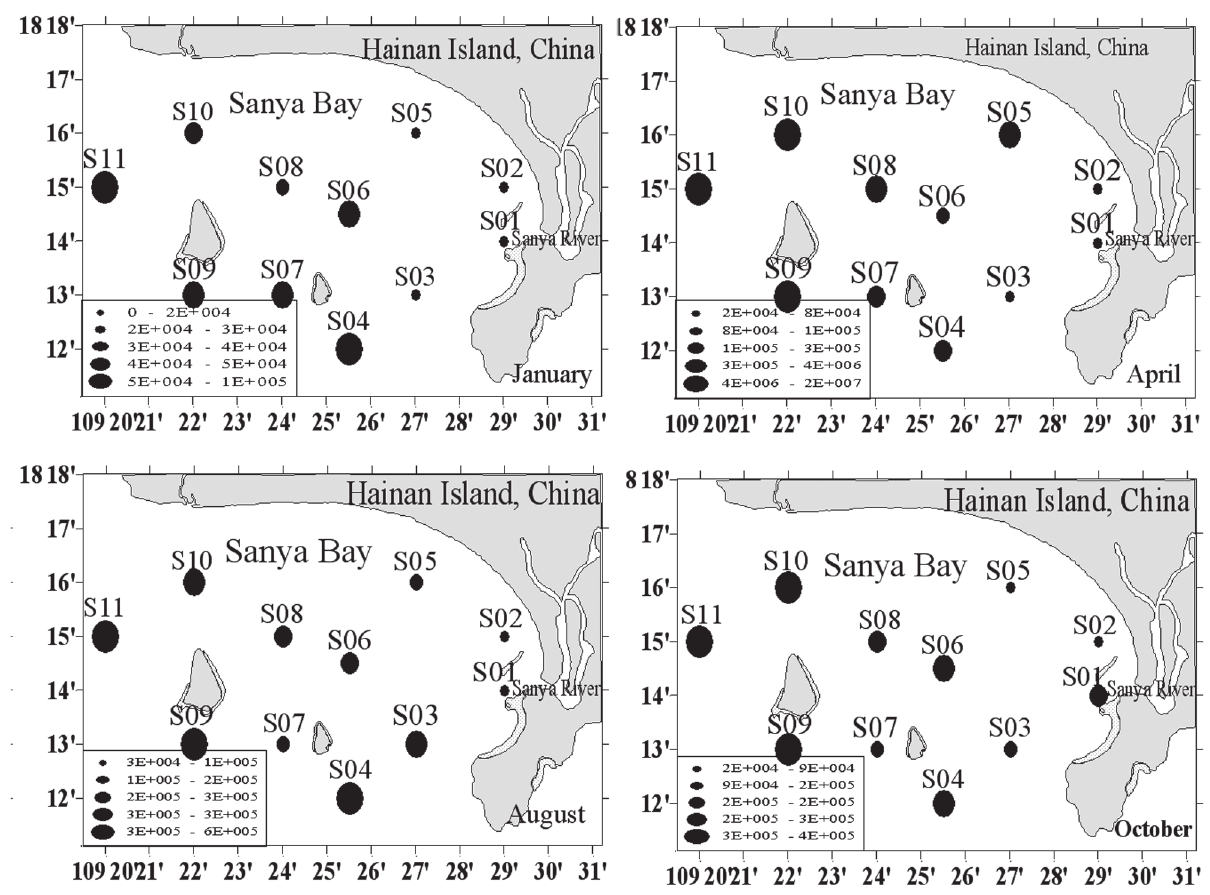
Fig . 3. – distribution of Trichodesmium spp. (trichomes m –2 ) in sanya Bay, in the 2004 Table 3. – nitrogen fixation rates (nmol n h -1 col -1 )* of Trichodesmium thiebautii collected in sanya Bay.